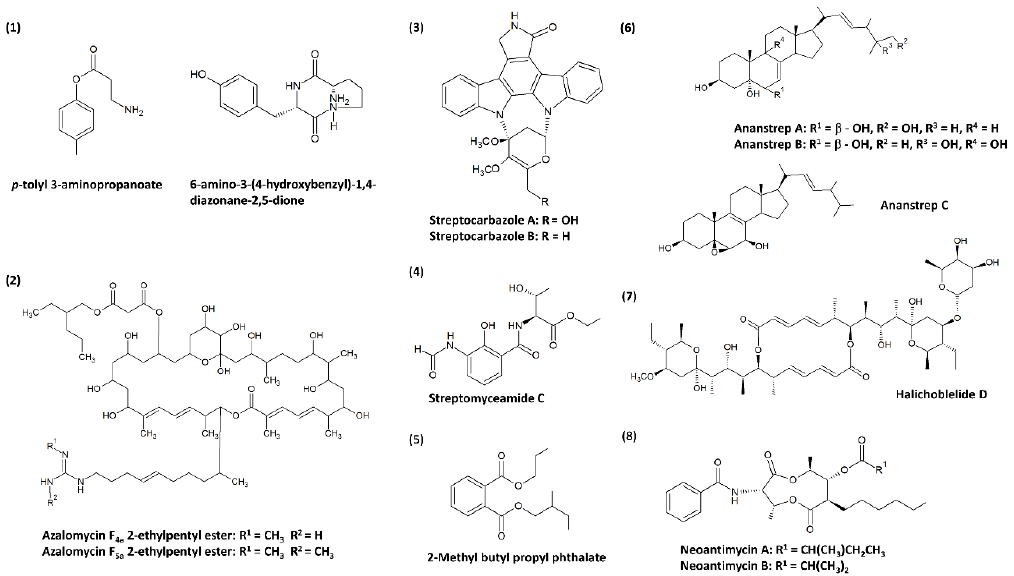
Figure 1. Chemical structures of the novel compounds produced by mangrove-derived streptomycetes. Chemical structures were obtained from the studies conducted by: ( 1 ) Xie et al. [99], ( 2 ) Yuan et al.